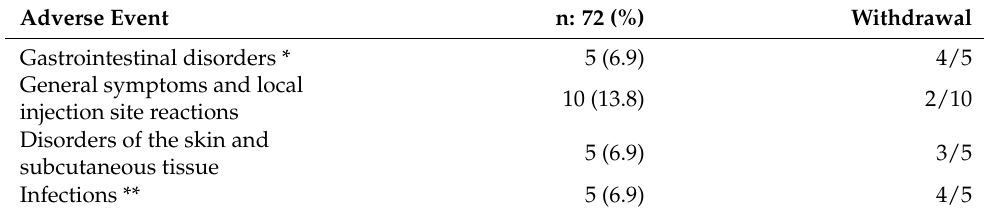
Table 2. Main adverse events identified during the study.